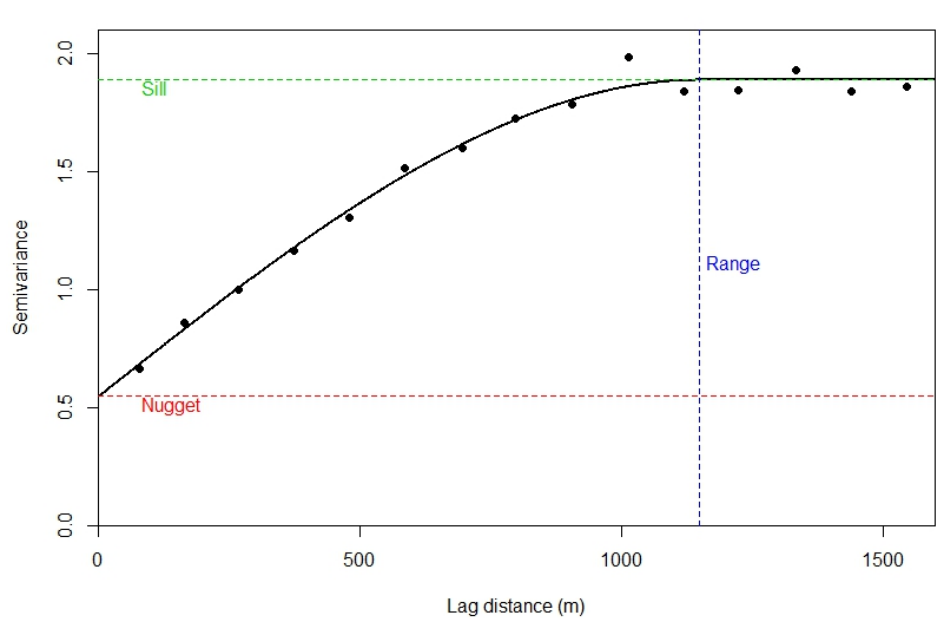
Figure 2. Illustration of the sample variogram (black points) and modelled variogram (black line). This is for an example dataset of heavy metals from the River Meuse in the Netherlands (Pebesma, 2004).